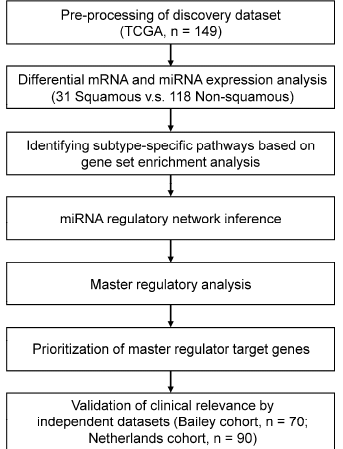
Figure 1. A schematic workflow for dissecting the squamous subtype-specific miRNA regulatory mechanism in PDAC using an integrative network-based approach.